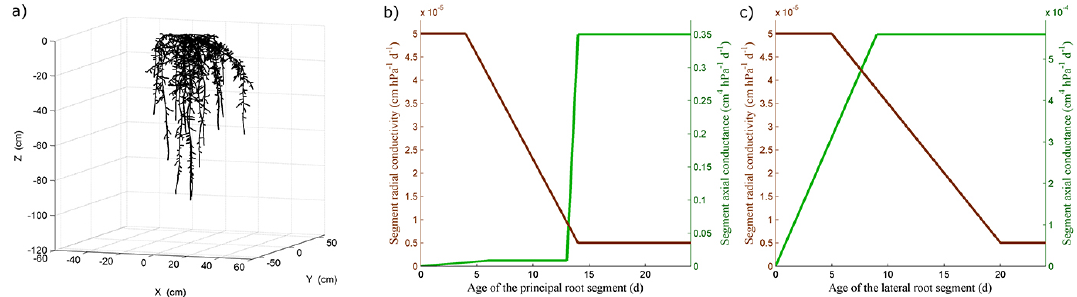
Fig. 2. Virtual winter wheat root system (a) architecture at early spring, and (b) principal and (c) lateral root segments’ hydraulic properties.